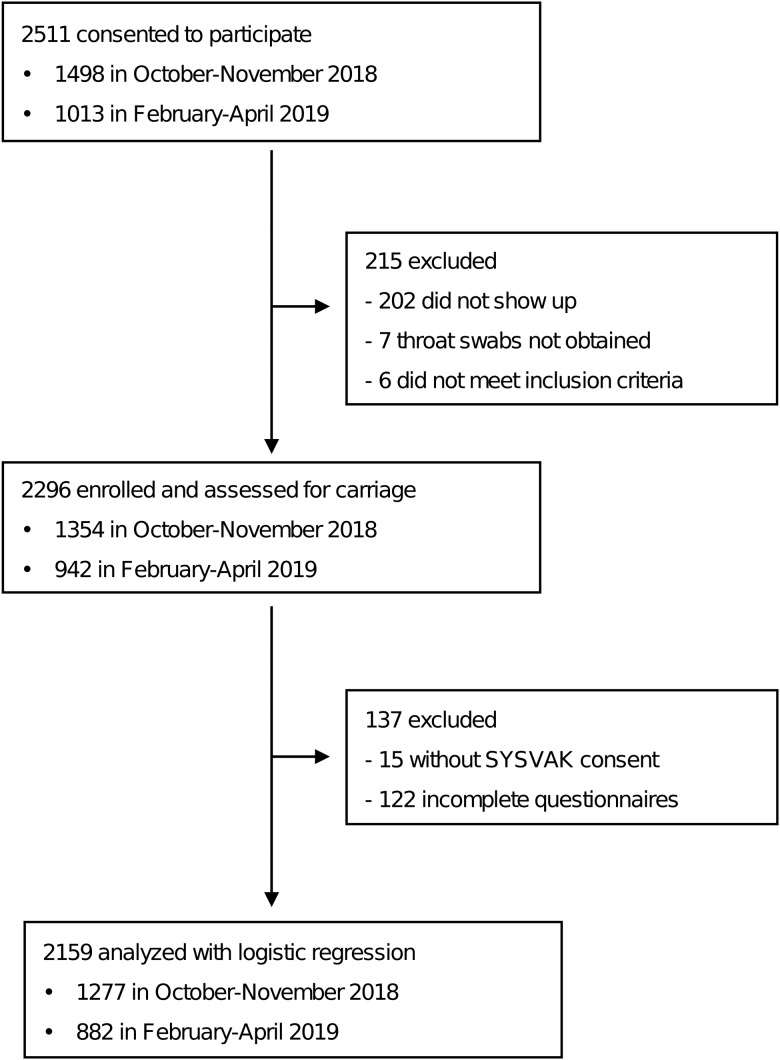
Flow-chart for inclusion of participants in the overall study with regards to sampling, consent for assessment of meningococcal vaccination status and completion of questionnaires. Number of participants in sampling period 1 (October–November 2018) and sampling period 2 (February–April 2019) are shown. SYSVAK = National Immunisation Registry SYSVAK.